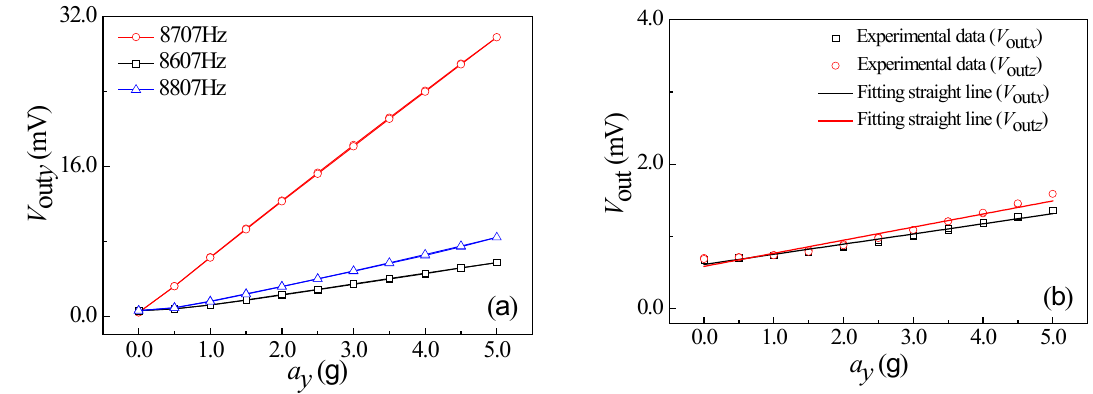
Figure 10. The relationship curves of output voltage and a y . ( a ) The characteristic curves of differential frequency variation. ( b ) The relationship curves between V out along nonsensitive axis and a y .